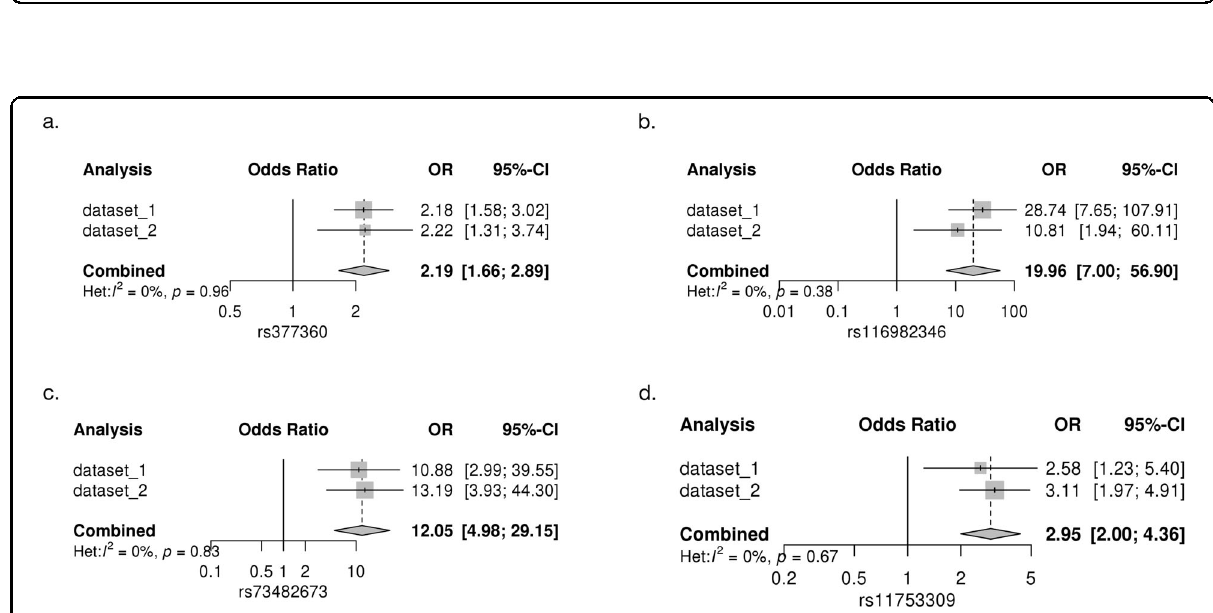
Fig. 3 Regional plots for the novel GWS loci. a ) rs377360. b ) rs116982346. c ) rs73482673. -log10P values are shown for SNPs for the region 500 kb on either side of the marker SNPs. The index SNP is shown in purple, and the r2 values of the other SNPs are indicated by color. The r2 values were established on the basis of 1000 Genomes East Asian (EAS) population data (November 2014). The genes within the relevant regions are annotated and shown as arrows.